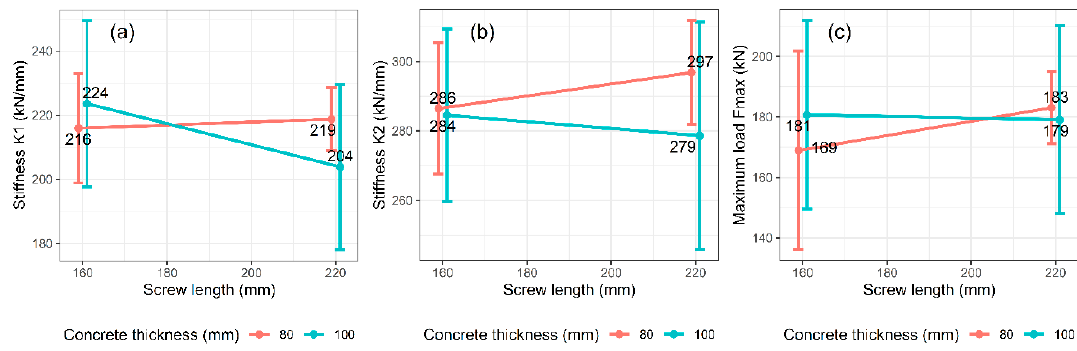
Figure 9. Stiffness K1 ( a ), K2 ( b ), and maximum load Fmax ( c ) in terms of screw length and concrete thickness.